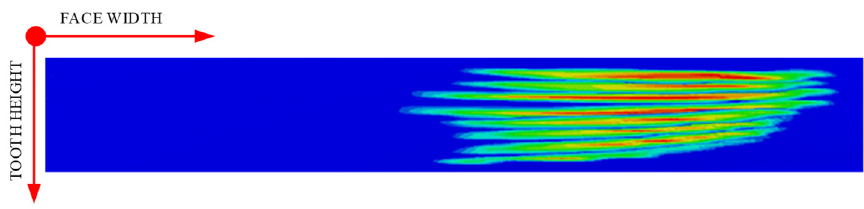
Figure 7. Stress nephogram in finite element simulation (red: maximum contact stress).